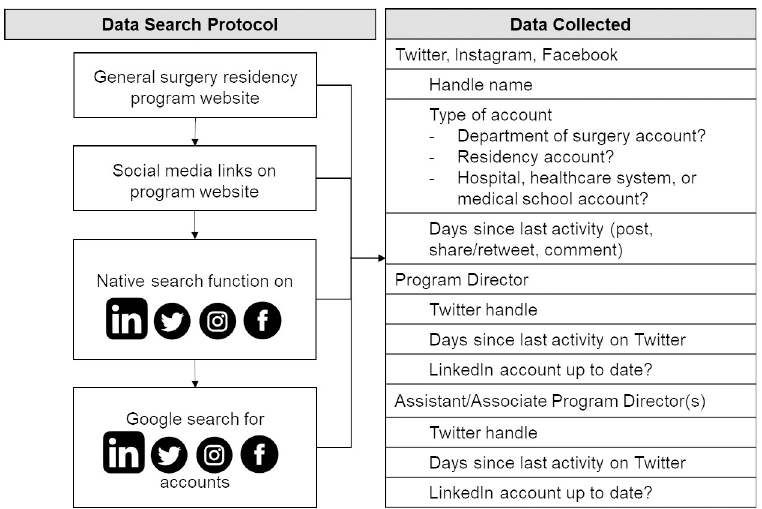
Fig 1. Search strategy protocol. A detailed stepwise protocol was used to guide data collection. Searches were first conducted using the complete name of a residency program; abbreviated versions of program names were also searched as needed. Abbreviated names were found on the program websites (e.g., “UAB” for University of Alabama at Birmingham, “MGH” for Massachusetts General Hospital). Program Director and Assistant or Associate Program Director accounts were found using complete name only; identity was confirmed using descriptions in their profile as a surgeon and/or their place of